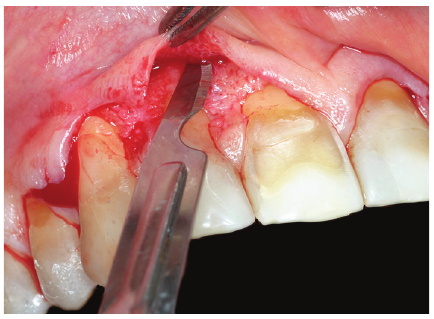
Figure 5: Release of muscle